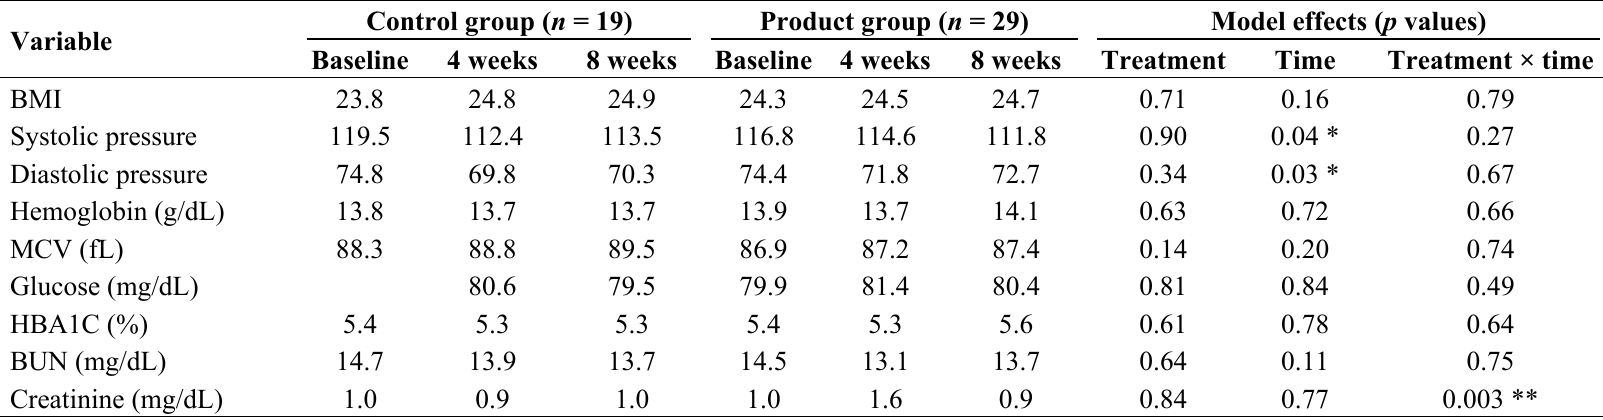
Table 4. Results of mixed model for relative changes in BMI, blood pressure and blood tests during 8 weeks of juice